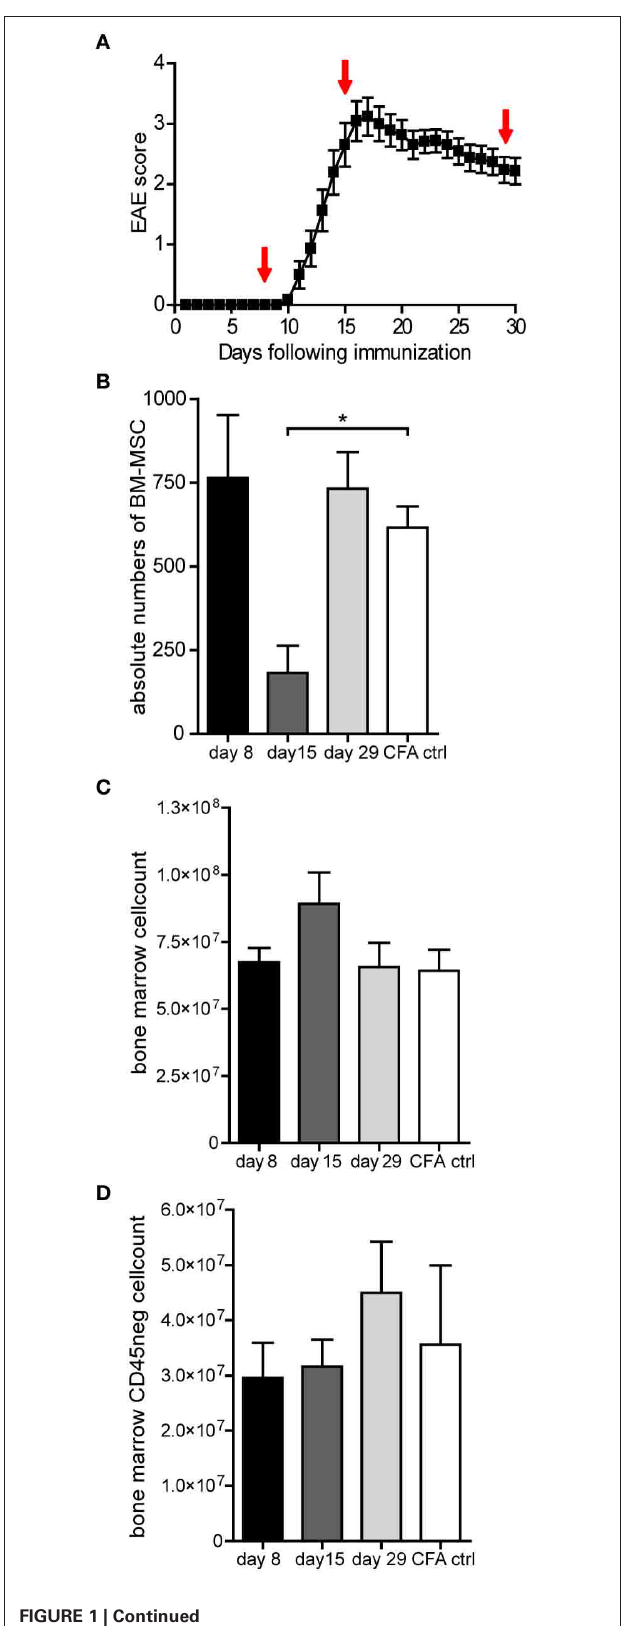
FIGURE 1 | The number of MSCs decreases transiently in the bone marrow during EAE. (A) Clinical signs of rMOG (1–125) induced EAE showing mean clinical scores ( ± SEM). Mice were examined daily for clinical signs of EAE and were scored as followed: 0, no disease; 1, limp tail; 2, hind limb weakness; 3, complete hind limb paralysis; 4, hind limb paralysis plus forelimb paralysis; and 5, moribund or dead. Bone marrow was isolated at day 8, 15, and 29 after immunization as indicated by arrows ( n = 3 per group). (B) Numbers of MSCs present in the bone marrow during the course of EAE analyzed at the indicated timepoints after EAE induction. Total numbers of MSCs were determined by colony forming unit (CFU) assay and numbers of CFUs are expressed as mean ± SEM ( n = 3 or more per group, one way ANOVA, ∗ p < 0 . 05). (C,D) Bone marrow cell counts and total number of CD45 neg cells of EAE mice during the course of EAE analyzed at the indicated timepoints. Data represent mean ± SEM of EAE induced mice ( n = 3 or more per